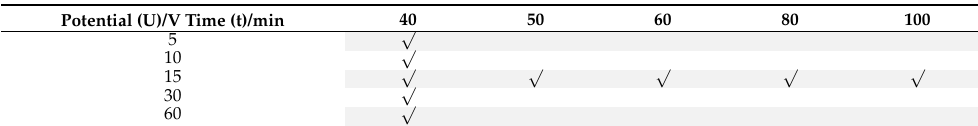
Table 2. Experimental conditions for the anodization of Ti15Mo samples in the ethylene glycol- based solution.